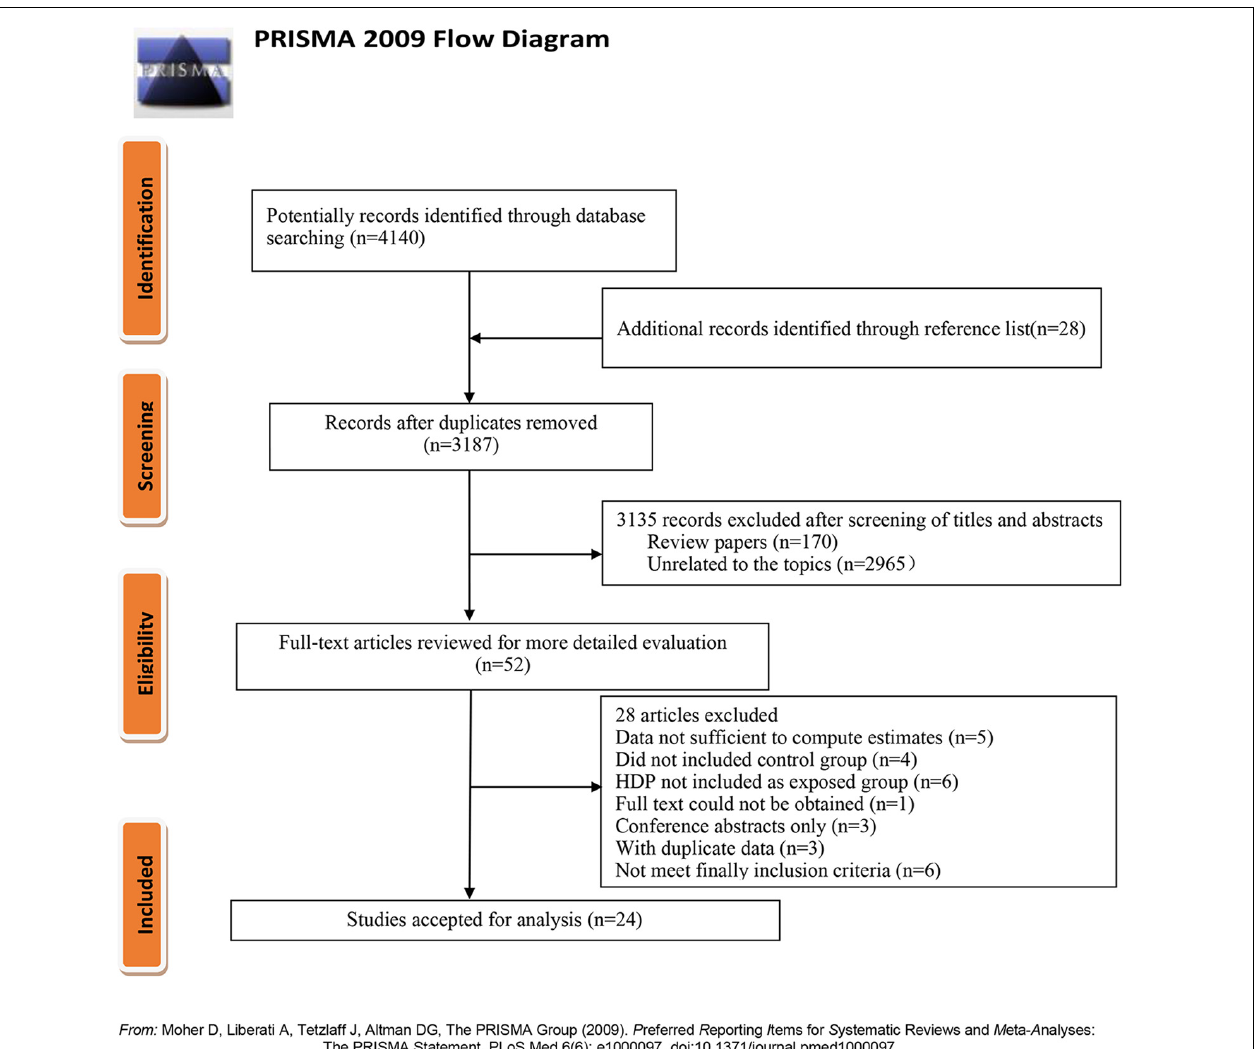
FIGURE 1 | Flow chart of literature